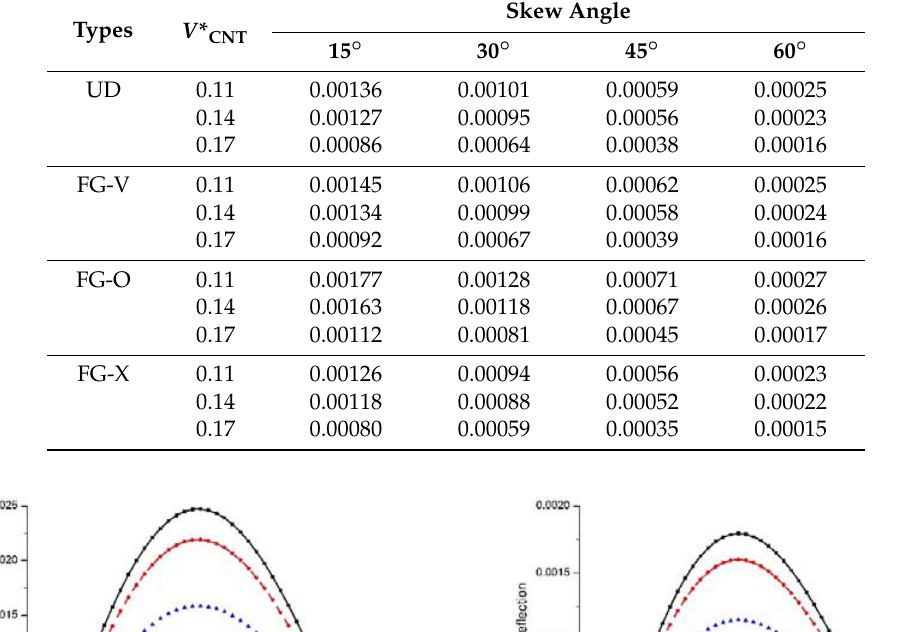
Table 17. Variation of non ‐ dimensional maximum deflection of FG ‐ CNT ‐ reinforced clamped rhombic plate under sin ‐ sin loading.